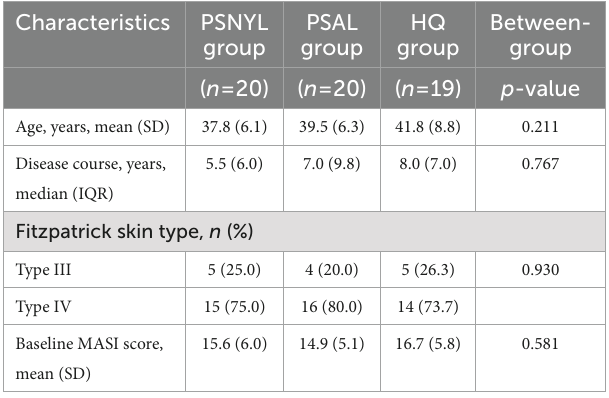
TABLE 2 Patients’ characteristics at baseline.